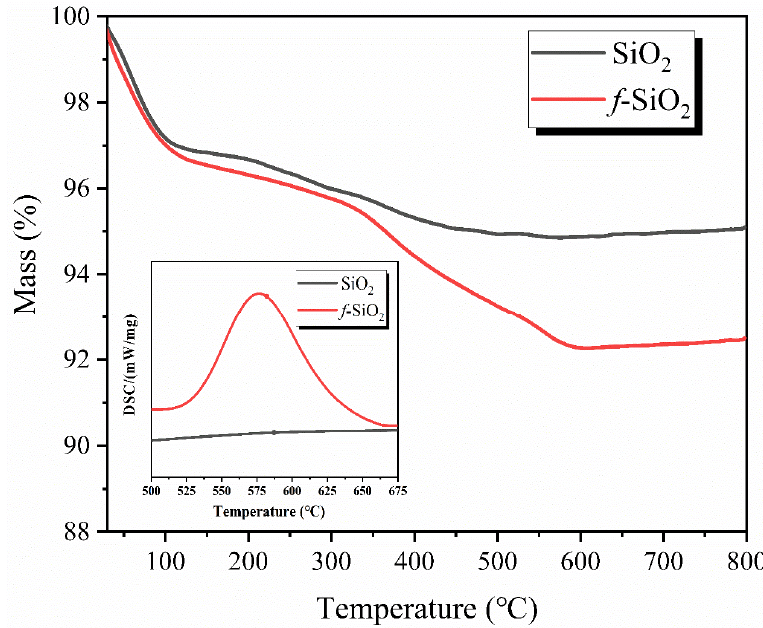
Figure 4. TG–DSC curves of SiO 2 and f -SiO 2 , respectively.